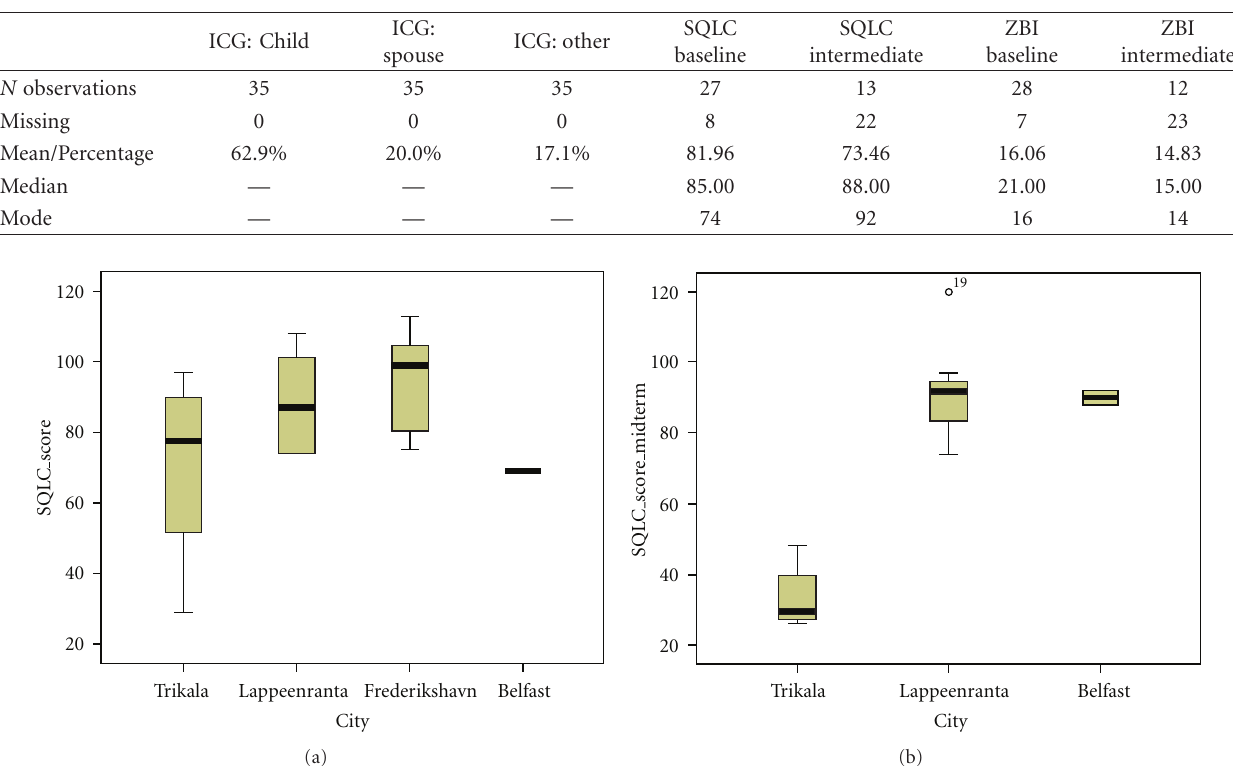
Table 4: ICG percentages, SQLC and ZBI baseline and intermediate scores.